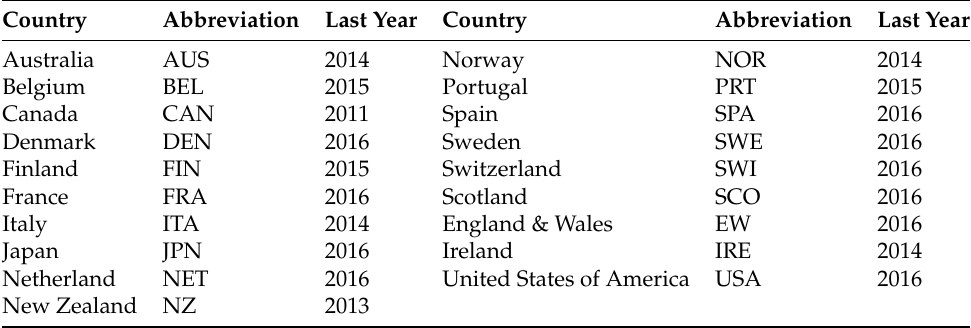
Table 1. The 19 countries with the initial year of 1950 and their ending year listed